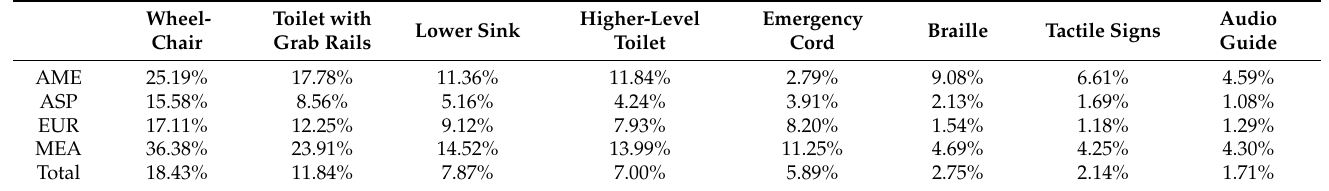
Table 3. Percentage of accessible facilities in hotels by region over all the hotels.